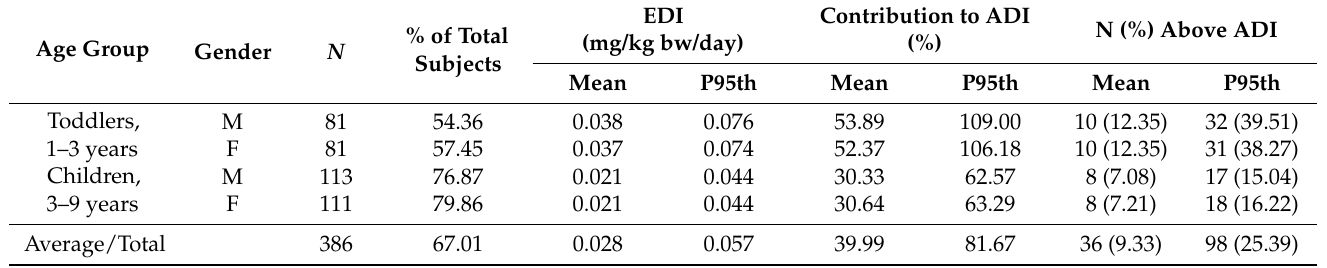
Table 5. EDI and risk characterization of nitrite ion (NO 2 − ) intake in consumers of processed meat products.